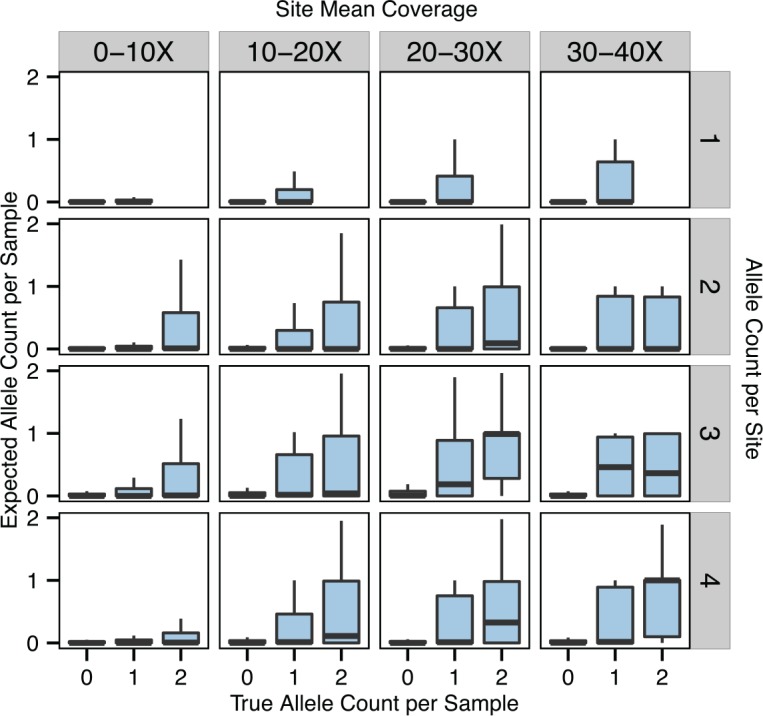
Expected non-cut restriction site allele counts.The true numbers of non-cut restriction site alleles carried by each sample are latent variables in the GBStools likelihood model. Boxplots representing the distributions of the expected values of these variables are shown here, and are grouped by the true non-cut allele counts inferred from Complete Genomics whole-genome sequencing data for HapMap samples. Allele counts of 0, 1 and 2 correspond to restriction site genotypes +/+, +/–and–/–respectively, where (–) is the non-cut allele. Plots are also grouped by site allele count (with 8 samples total) and site mean coverage. Only sites with allele frequencies between 0.0625–0.25 are shown.